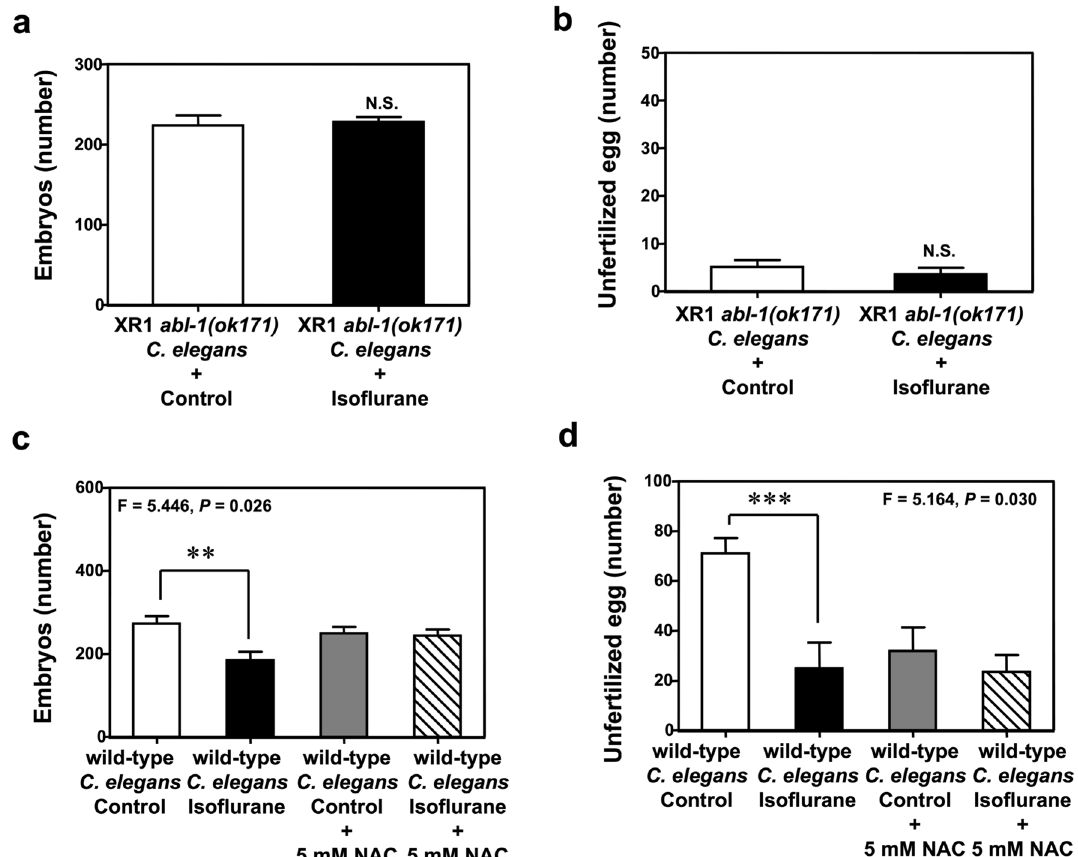
Figure 4. Isoflurane impaired oogenesis via an abl-1- associated oxidative stress-related pathway. ( a ) Treatment with 7% isoflurane for 4 h did not decrease the number of embryos produced by abl-1 knockout hermaphrodites. ( b ) Treatment with 7% isoflurane for 4 h did not decrease the number of unfertilized eggs produced by abl-1 knockout hermaphrodites. ( c ) Treatment with 5 mM N-acetyl-cysteine (NAC) in wild-type C. elegans mitigated the isoflurane-induced reduction in the number of embryos produced by N2 hermaphrodites. ( d ) Treatment with 5 mM NAC attenuated the isoflurane-induced reduction in the number of unfertilized eggs produced by N2 hermaphrodites. All data are presented as mean ± S.D. N = 10 hermaphrodites in each group. The Student’s t-test was used to analyze the data presented in ( a , b ); the P values refer to the difference between the control condition and isoflurane. Two-way ANOVA and posthoc Bonferroni test was used to analyze the data presented in ( c , d ); the P values refer to the interaction of group (control condition versus isoflurane) and treatment (vehicle versus NAC), and the difference between each treatment. ** P < 0.01, *** P < 0.001. XR1: C. elegans strain abl-1(ok171) ; NAC